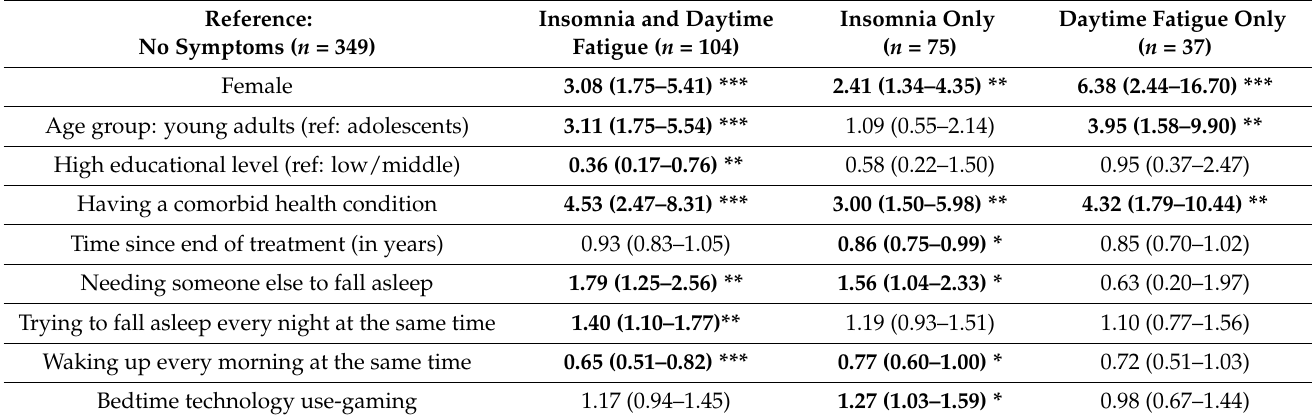
Table 3. Risk factors for insomnia–daytime fatigue subgroups compared to no symptoms: results of the final multinomial regression model, multivariable (OR and 95%